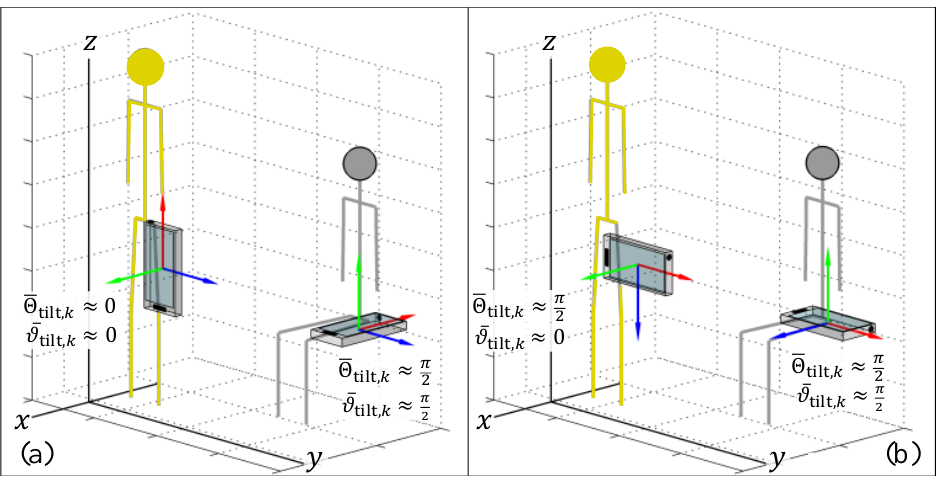
Figure 3. Two alternative methods for measuring the tilt. The limitations of the traditional tilt angle variable (i.e., the angle between the red basis vector and the z -axis of the global frame of reference (GFR)) are clear, making it impossible to separate standing (stick figure in gold) and sedentary periods (stick figure in grey). When the red basis vector: ( a ) runs along the length of the individual’s leg, the magnitude of the tilt angle changes by ≈ π radians (i.e., 90°) between standing and sedentary 2 periods, making it easy to discriminate these postures; ( b ) red basis vector runs along the mediolateral axis of the individuals’s leg, so the magnitude of the tilt angle of the red vector remains relatively unchanged between standing and sedentary periods, resulting in confusion between the two